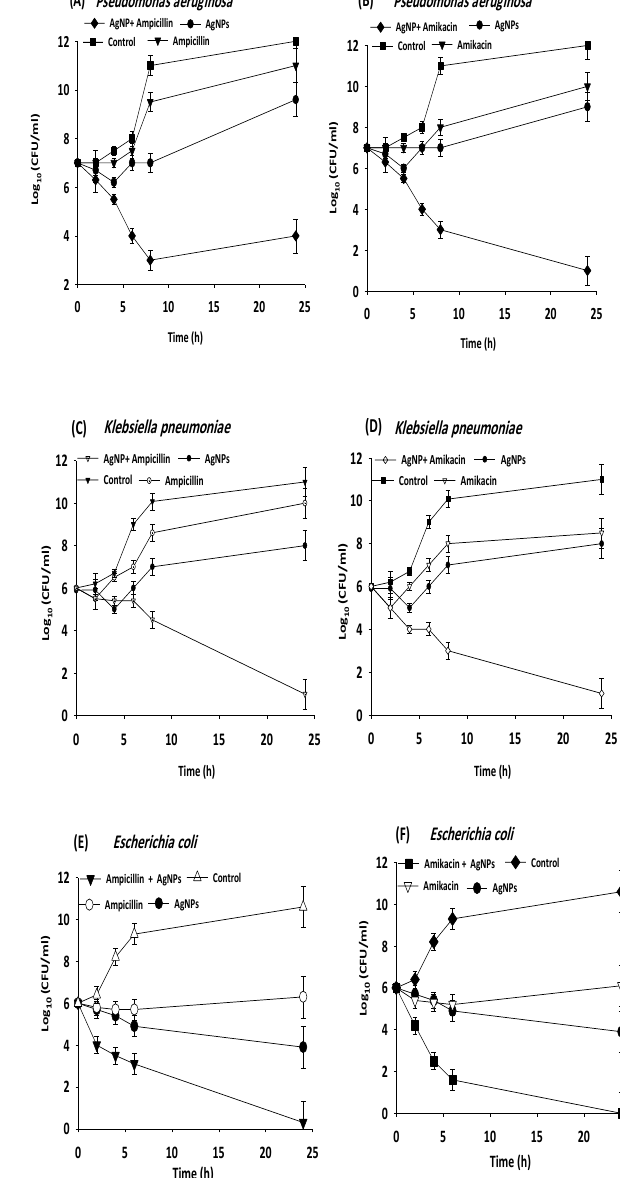
(Figure 5. A, B). In additions, the two-drug combinations of sub-MIC(½ MIC) of AgNPs with either ½ MIC of ampicillin or ½ of amikacin exhibited synergistic effect against K. pneumoniae and E. coli with clear inhibition of microbial growth curve after 6 h and 24h of incubation (Figure 5. C-